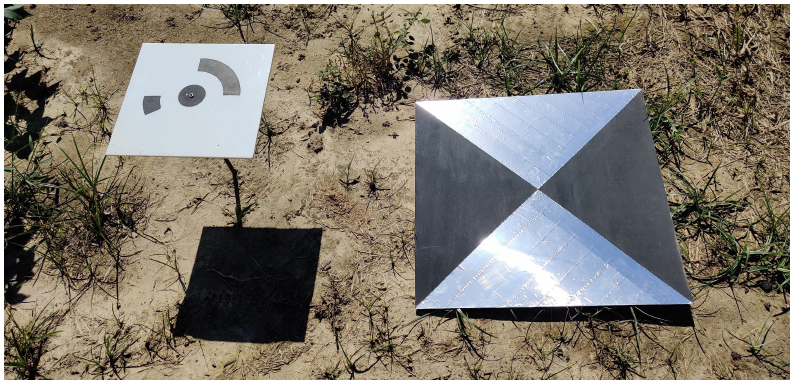
Figure 9. GCPs in the field, including GCP for RGB and multispectral cameras ( left ) and GCP for thermal camera ( right